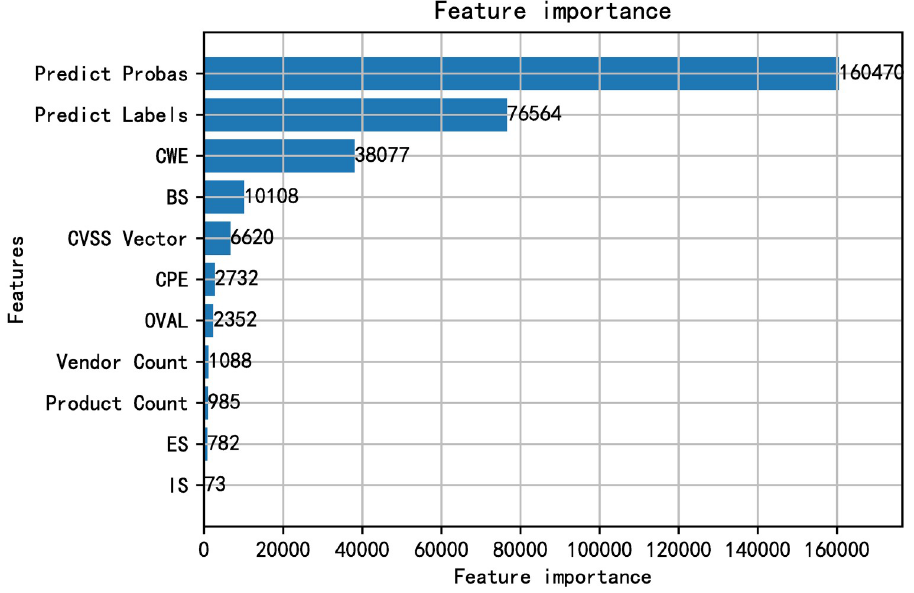
Fig 13. Feature importance ranking when performing fastEmbed model on